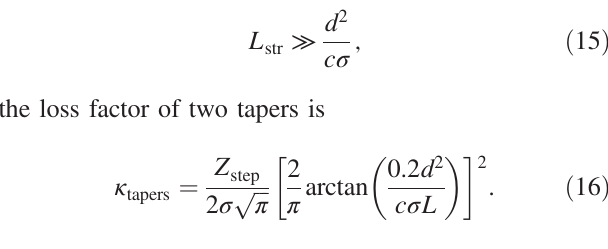
lengths.FIG. 6. The impedance spectrum for different lengths of the taper-out (ABCI simulation results). The dashed line is the impedance of the step Z [see, Eq. (11)], and the dotted line step = 2 . is Z step